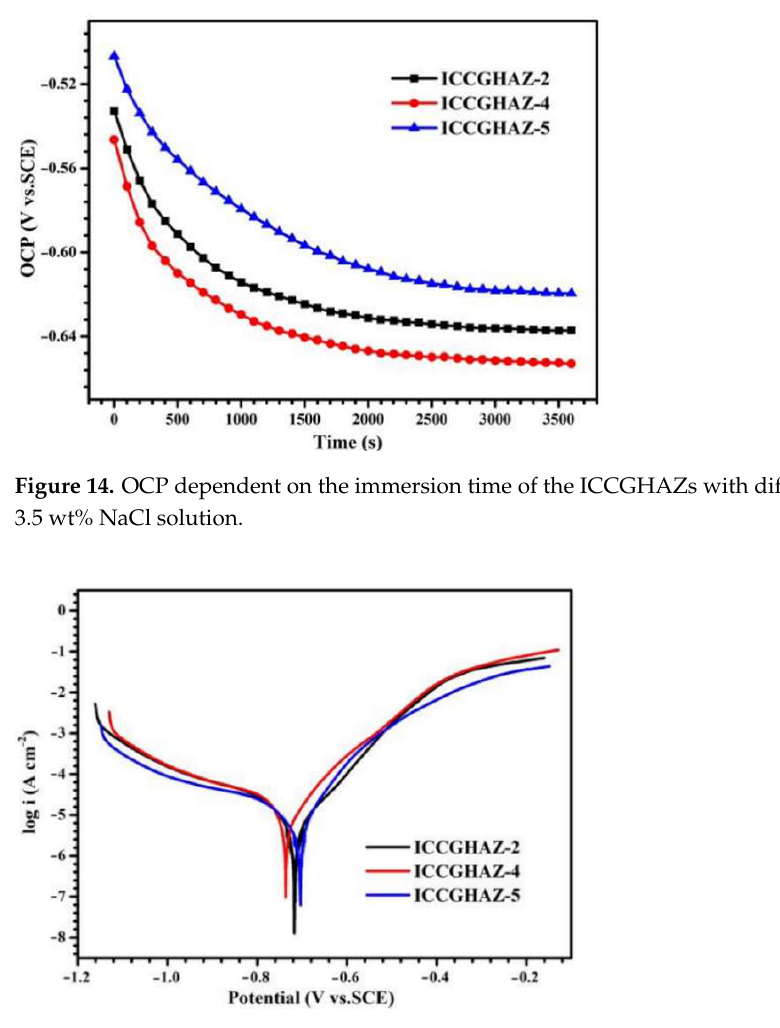
Figure 15. Potentiodynamic polarization curves of the ICCGHAZs with different cooling rates in 3.5 wt% NaCl solution.